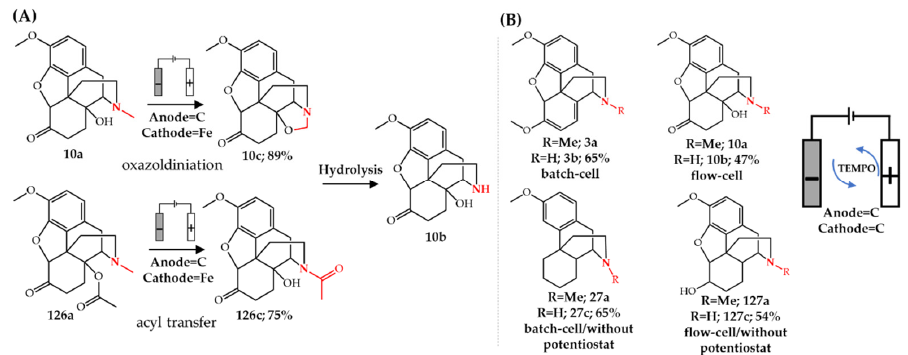
Figure 17. ( A ) Electrochemical oxazolidination and acyl transfer and ( B ) TEMPO ‐ mediated electro ‐ chemical N ‐ demethylation of opiate alkaloids.